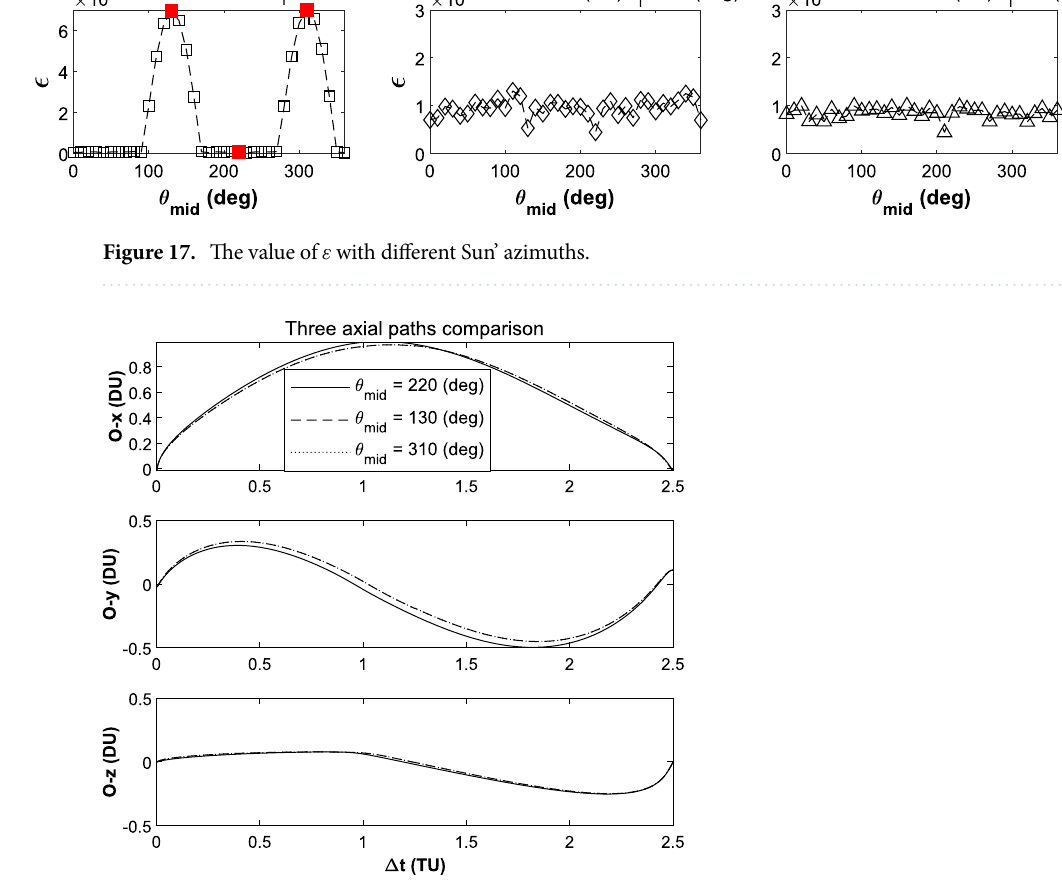
Figure 18. Three axial paths